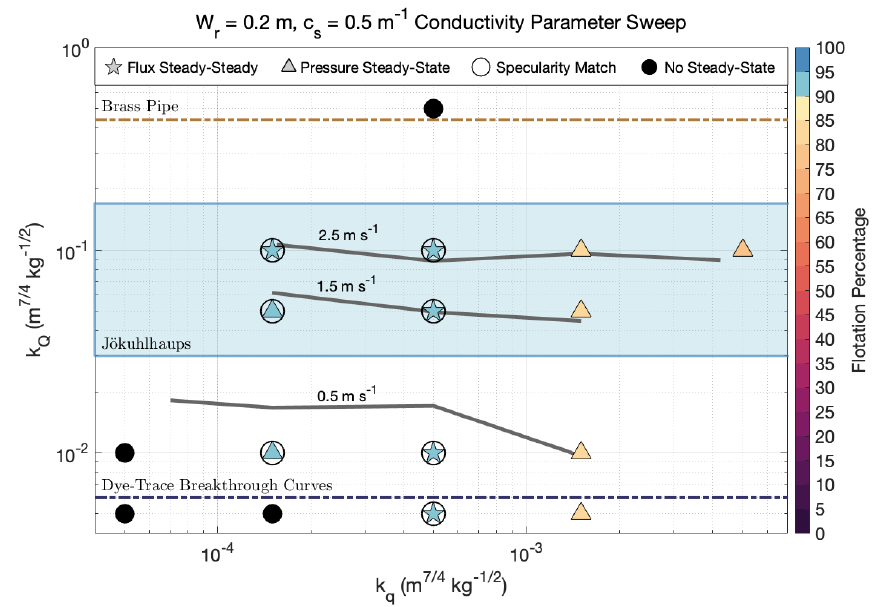
Figure A4. Same as Fig. 4 but for bed roughness parameters W r = 0 . 2m and c s = 0 . 5m − 1 .